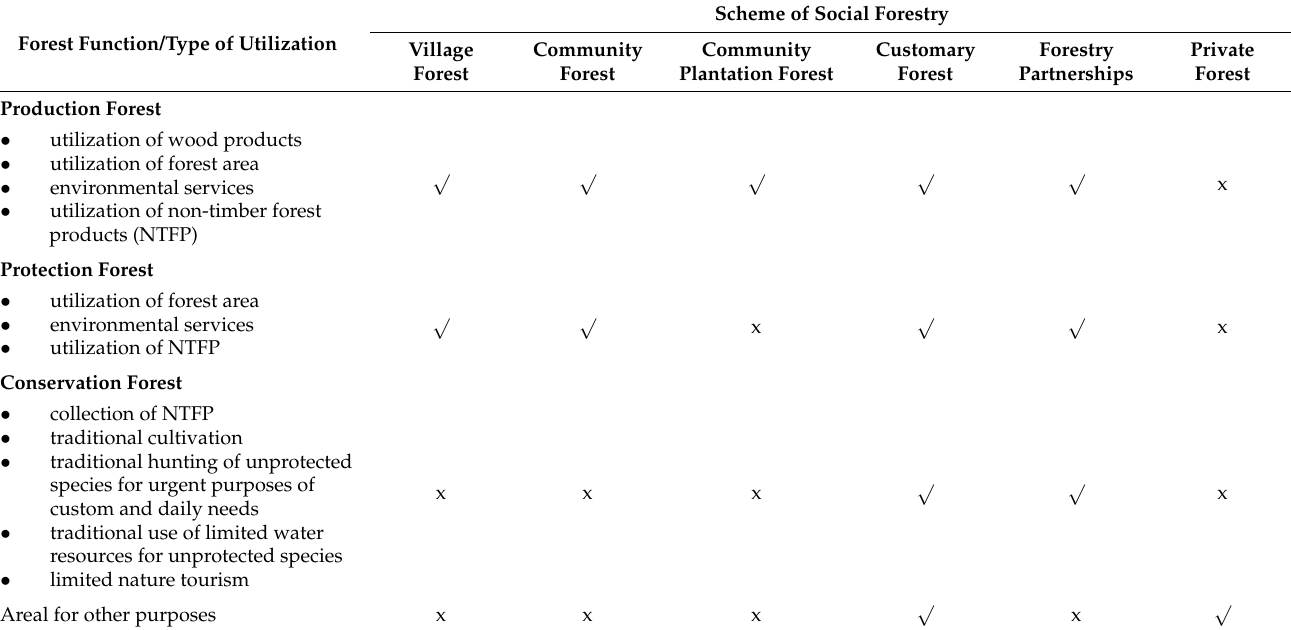
Table 1. Social forestry schemes for various forest